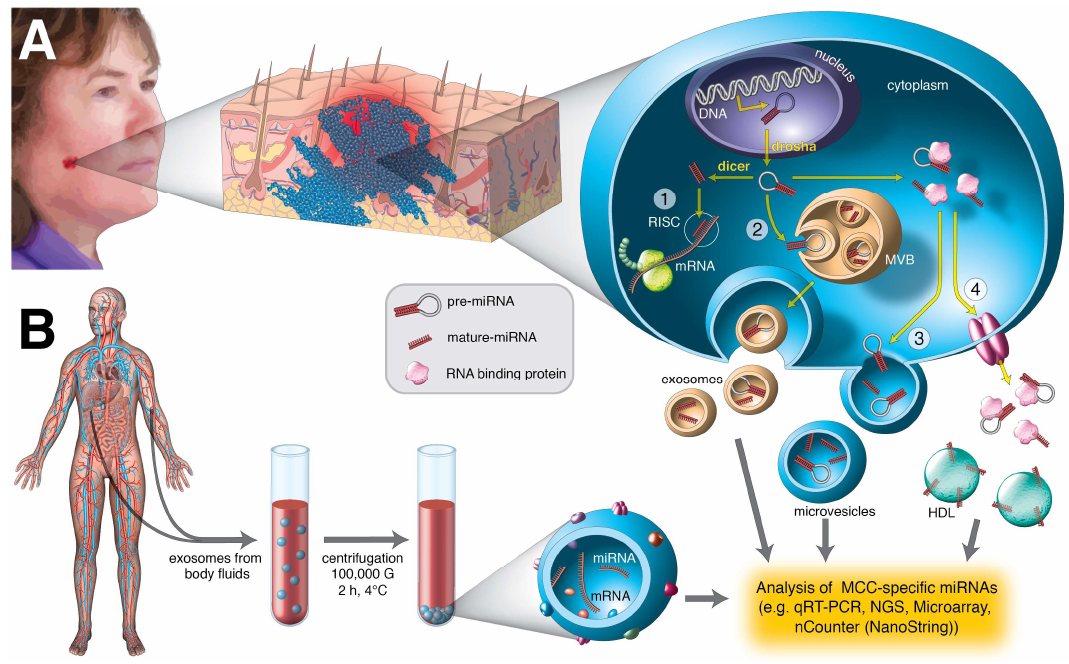
Figure 1. Detection of MCC-specific miRNAs from tumor biopsies or from body fluids. ( A ) The presence of intracellular or/and extracellular MCC-specific miRNAs is examined by qRT-PCR using specific primers. Intracellular miRNAs are amplified from a total RNA isolated from MCC tumor tissue, while extracellular miRNAs are amplified from a RNA extracted from purified exosomes or from the extracellular environment. The biogenesis of a miRNA is shown. A pre-miRNA is transported from the nucleus to the cytoplasm, and when processed to mature miRNA, it binds target mRNA (step 1). Pre-miRNAs and miRNAs can also be enclosed in vesicles and excreted in exosomes (step 2) or other extracellular vesicles (step 3). Pre-miRNAs and miRNAs can also release from the cell in complex with RNA-binding proteins, such as Argonaut 2 or nucleophosmin-1, or in complex with high-density lipoproteins (step 4); ( B ) circulating exosomes are purified from body fluids (e.g., blood, urine, lymphatic fluid, saliva) and a total RNA is extracted. MCC-specific miRNAs are subsequently detected by qRT-PCR applying specific primers, next-generation sequencing (NGS), microarray or nCounter.